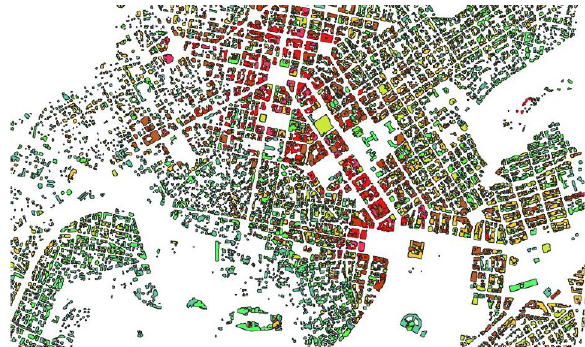
Figure 15: Polygons of buildings detected in the entire study area; higher (red) buildings are located around major road axes, whereas smaller (blue) buildings are mostly found in residential